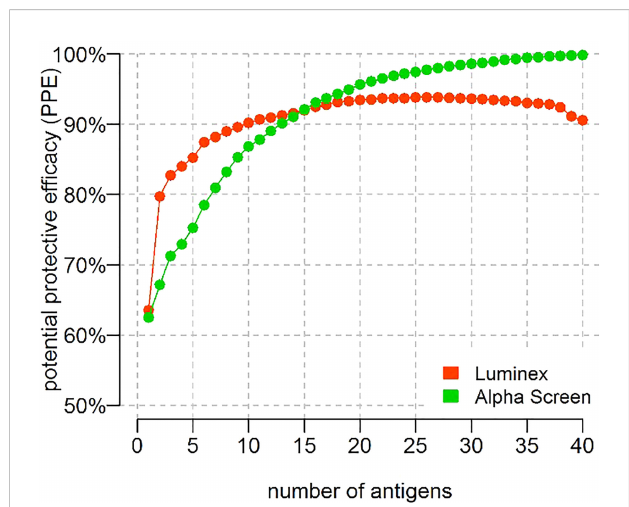
FIGURE 4 PPE with increasing numbers of P. vivax antigens. PPE with increasing numbers of antibody responses against P. vivax antigens included in a stepwise manner. Green: AlphaScreen data and Red: Luminex data. Note the antigens used on each platform were not the same. Note that for large combinations of antigens the statistical model will increasingly fi t to random noise in the